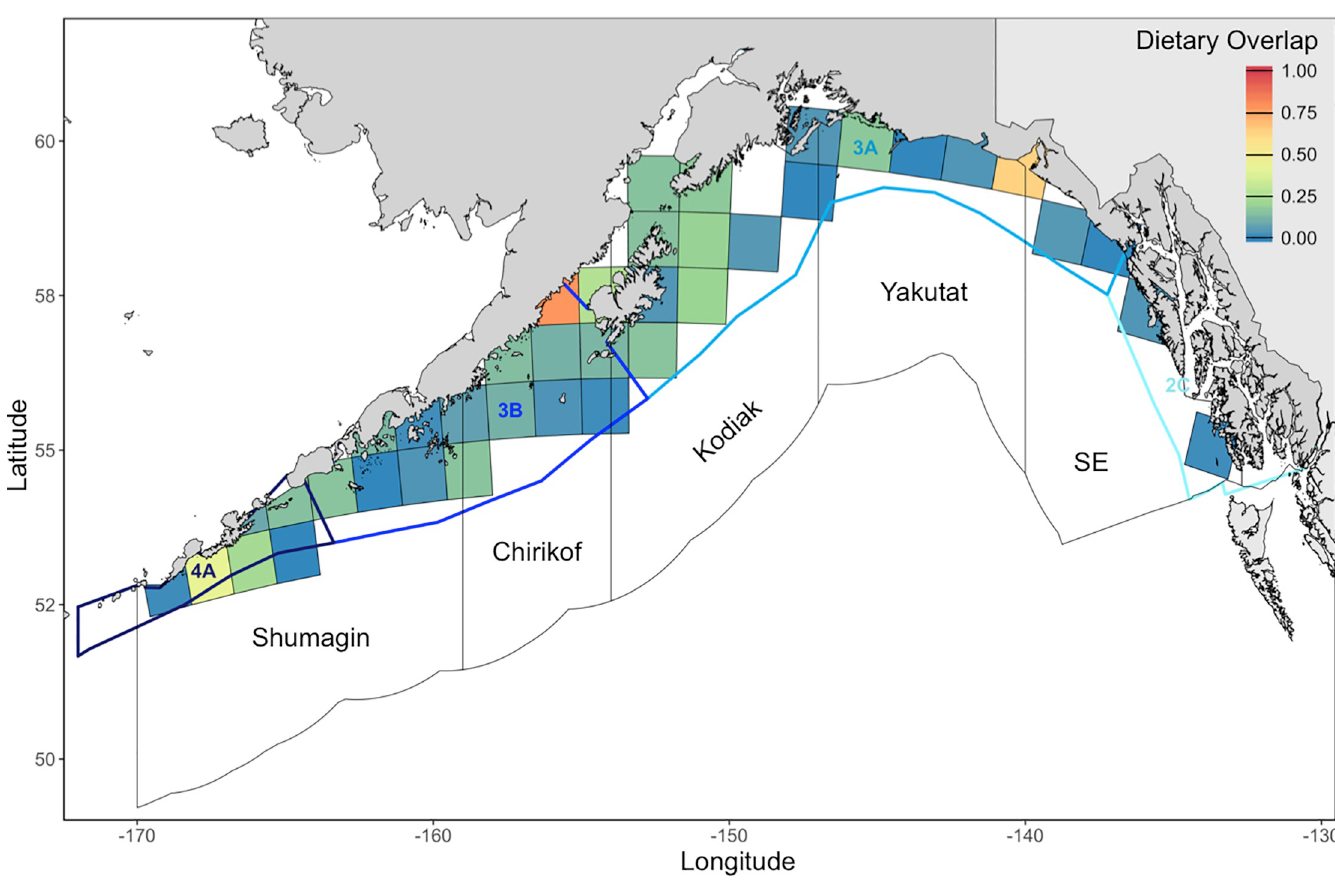
Fig 6. Mean dietary overlap between Pacific Halibut and Arrowtooth Flounder (1990 to 2013). Filled squares represent individual 100 km x 100 km grid cell estimates. Polygons denote International North Pacific Fisheries Commission (INPFC) statistical areas (black outlines) and International Pacific Halibut Commission (IPHC) regulatory areas (blue-shaded outlines) in the Gulf of